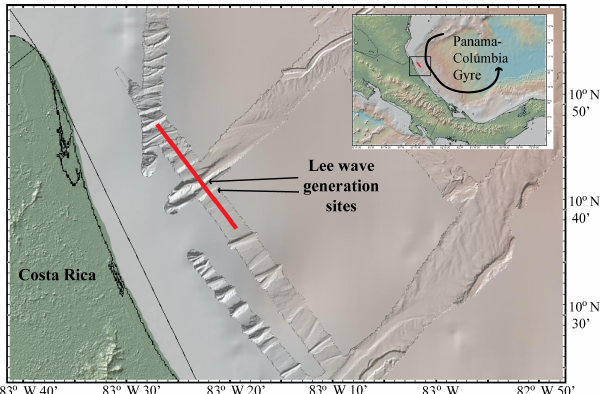
Figure 1. Location map of seismic line Limon1. The flow inter- action of the Panama–Columbia Gyre (Richardson, 2005) with the rough bathymetry creates lee waves along the transect in two loca- tions.